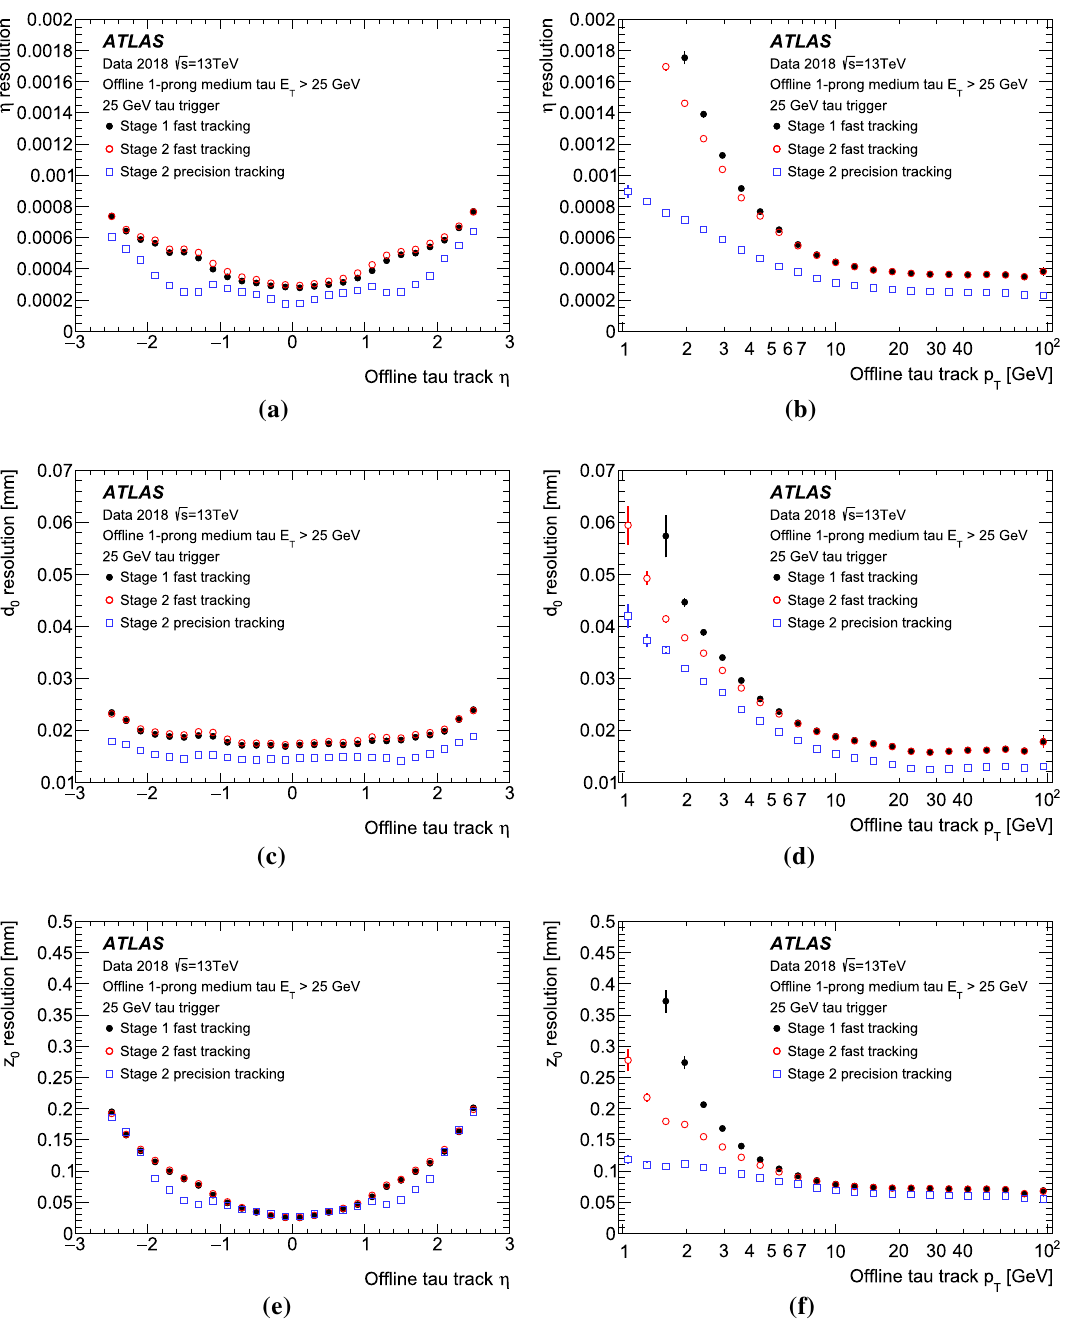
Fig. 33 The tau signature tracking resolution in a , b pseudorapidity, c , d transverse impact parameter, and e , f track z position along the beam line, all as functions of the matching offline track pseudorapidity and transverse momentum centre of each RoI in z , at the position of the primary vertex identified in the first stage. These second stage RoI have a smaller extent, (cid:7) z < 10 mm, about this z position. Only the tracks from the precision tracking of the second stage are used for the b -jet selection. The precision tracks are also used in the trigger for the global sequential jet energy calibration